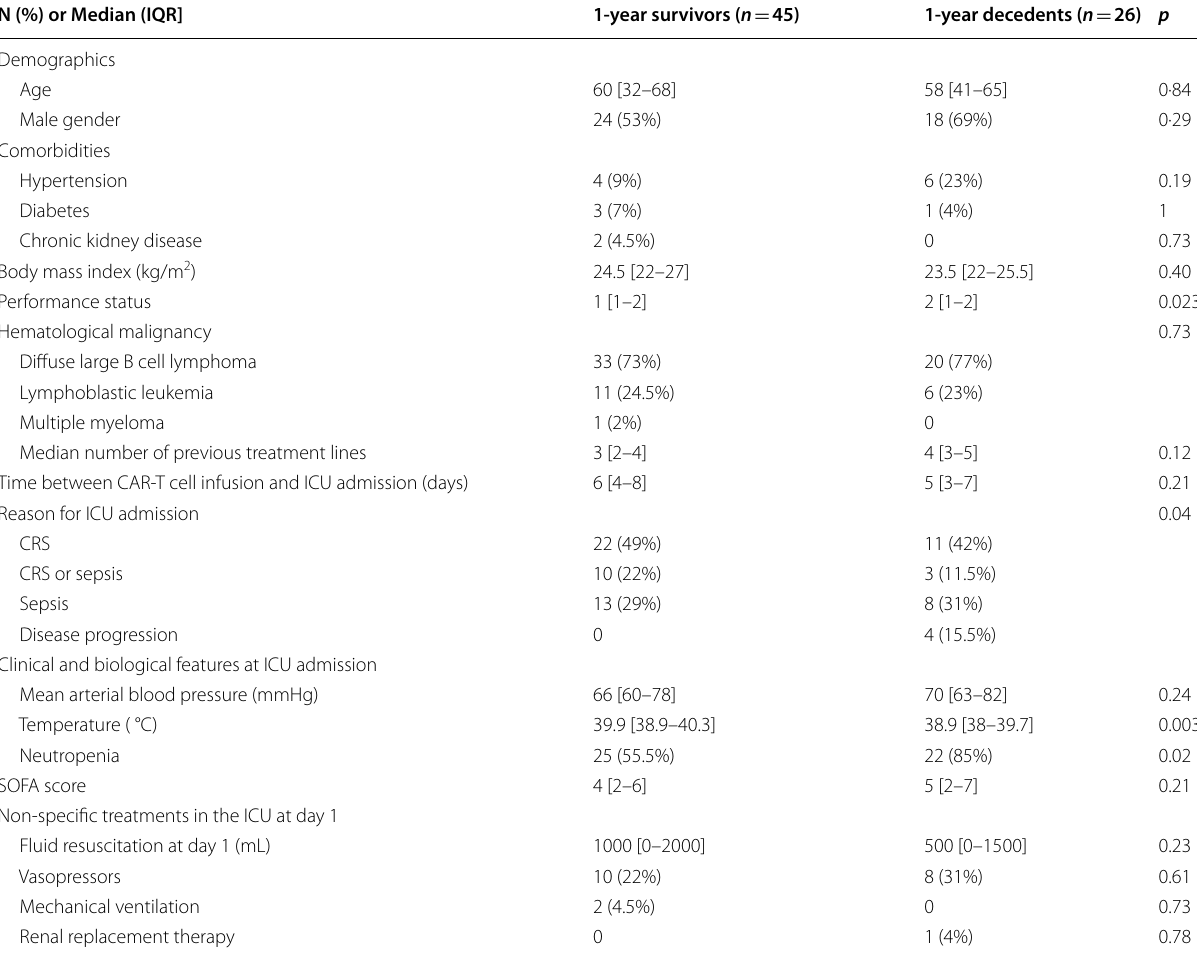
CRS cytokine release syndrome, ICU intensive care unit, SOFA sepsis-related organ Failure